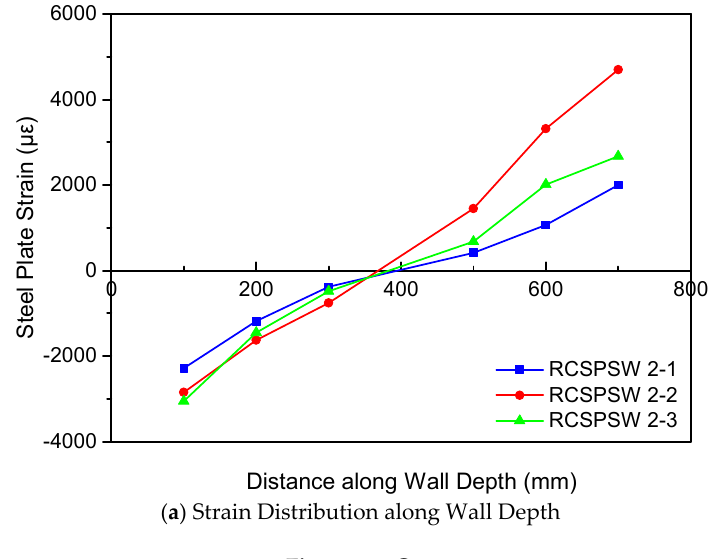
( a ) Strain Distribution along Wall Depth Figure 19.